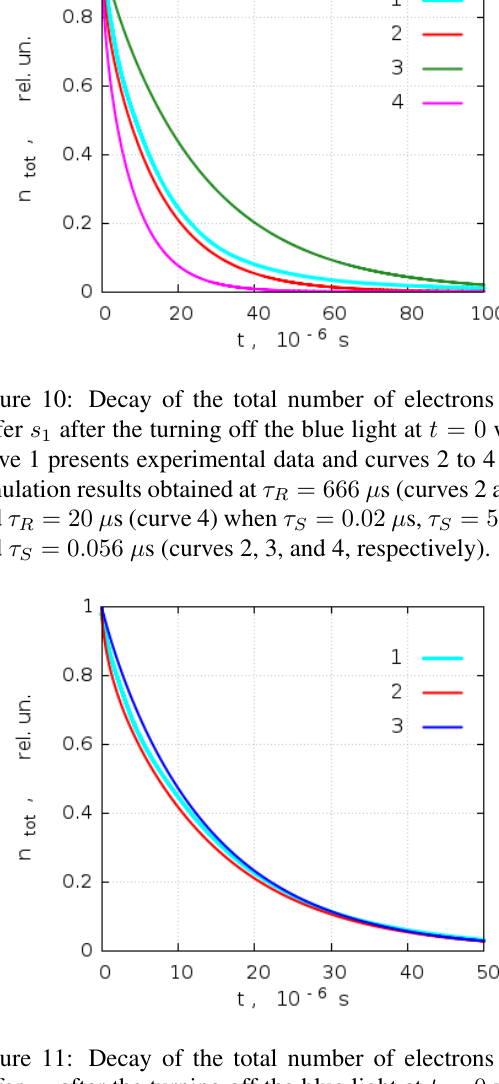
Figure 11: Decay of the total number of electrons in Si wafer s 1 after the turning off the blue light at t = 0 where curve 1 shows experimental data and curves 2 and 3 show simulation results at τ R = 666 µ s, τ S = 0 . 02 µ s and τ R = 20 µ s, τ S = 35 µ s,